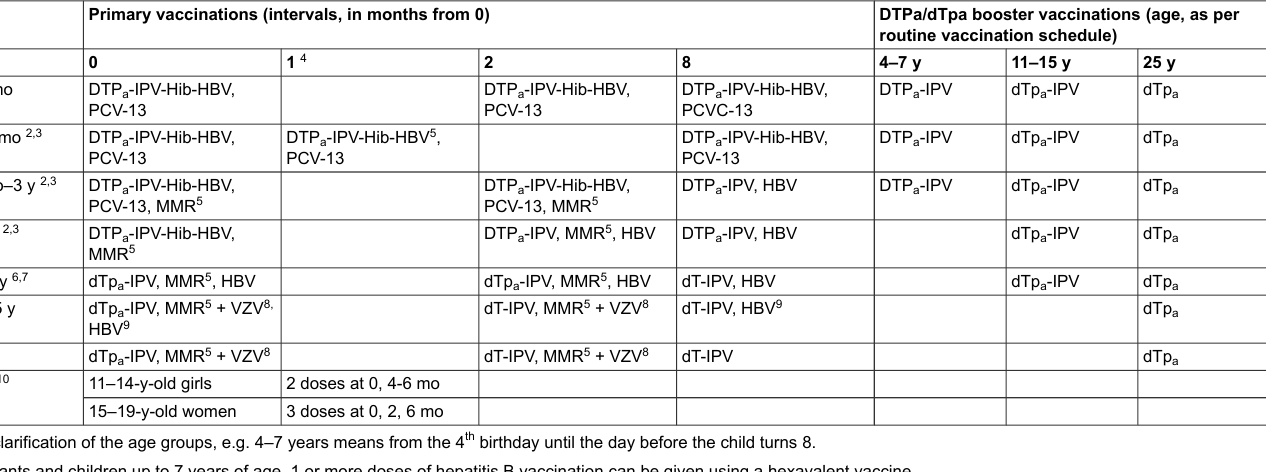
Table 1: Vaccination schedule for unimmunised children and adolescents. Primary vaccinations (intervals, in months from 0)